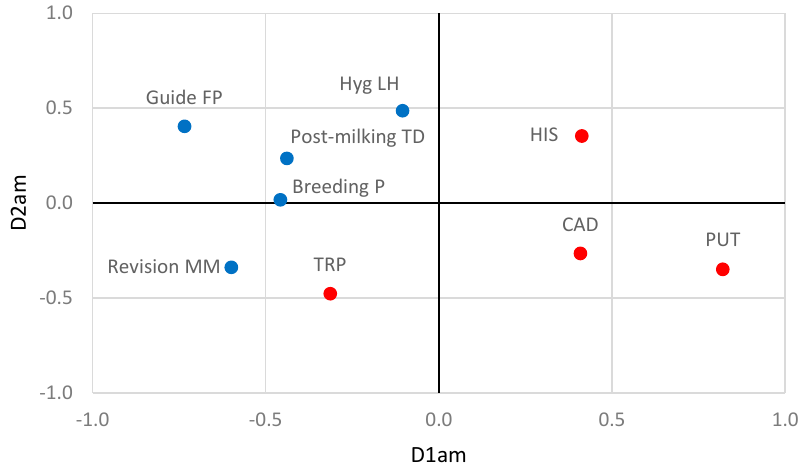
Figure 3. Nonlinear canonical correlation analysis similarity map determined by the first (D1am) and second dimension (D2am) for farming practices ( • ) and biogenic amines ( • ). Leyend: Breeding P = Breeding program, Guide FP = guide to good farming practices, Hyg LH = hygiene of the livestock housing, Postmilking TD = Postdipping teat disinfection, Revision MM = periodic check-up of the milking machine, HIS = histamine, PUT = putrescine, TRP = tryptamine, CAD =